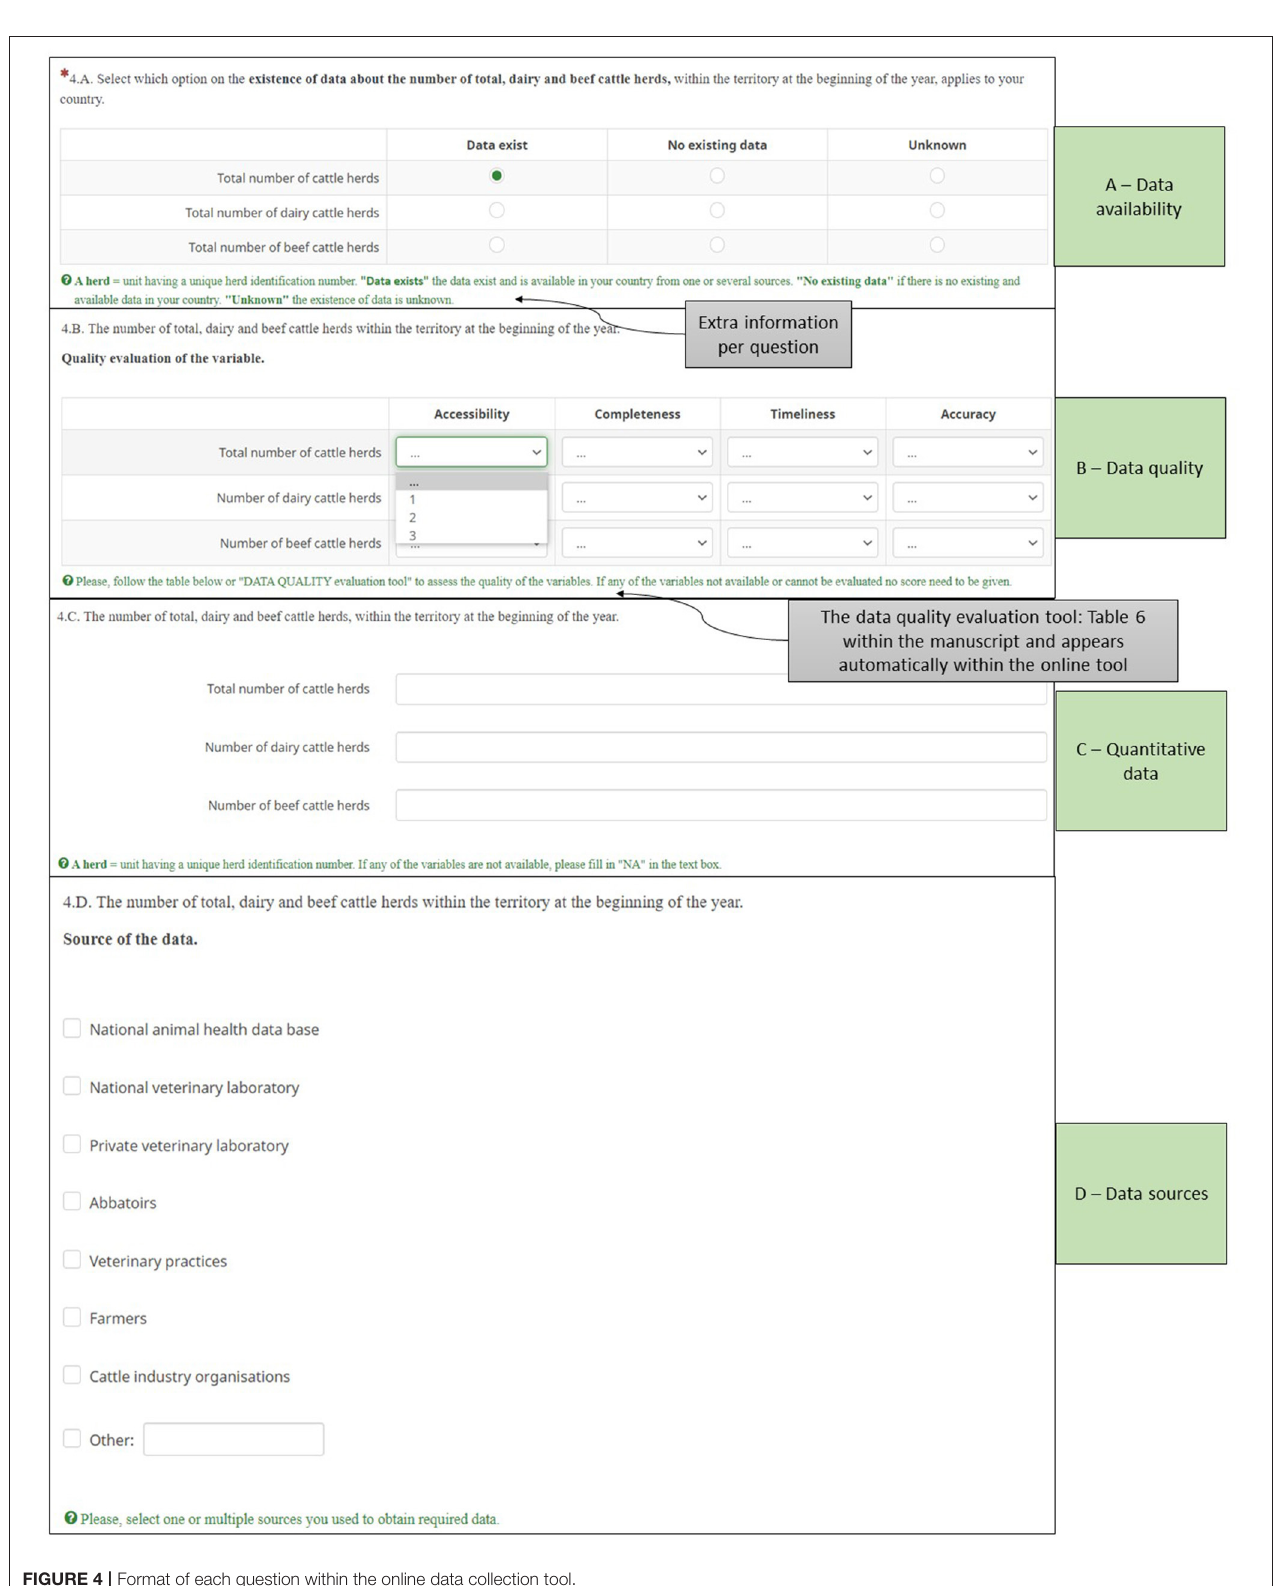
FIGURE 4 | Format of each question within the online data collection